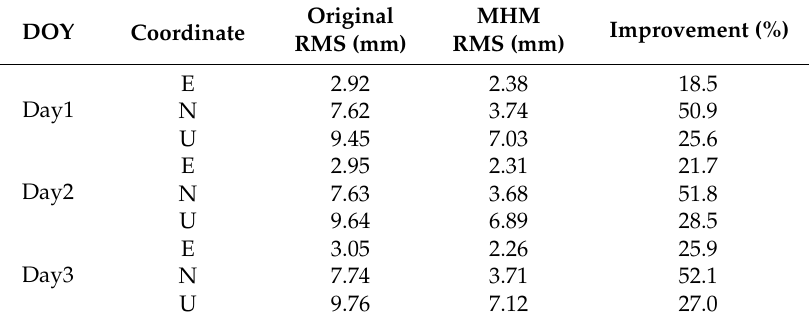
Table 6. RMS of coordinate